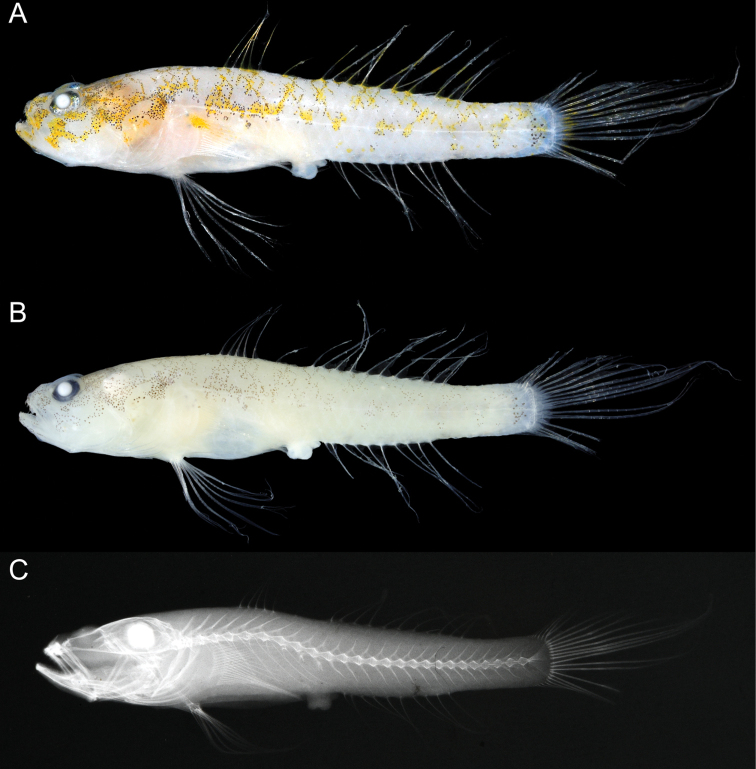
Holotype of Egglestonichthys
fulmen sp. nov., OMNH-P 43993, 21.7 mm SL, Okinawa Island, Ryukyu Islands, Japan A fresh colorationB preserved colorationC radiograph.